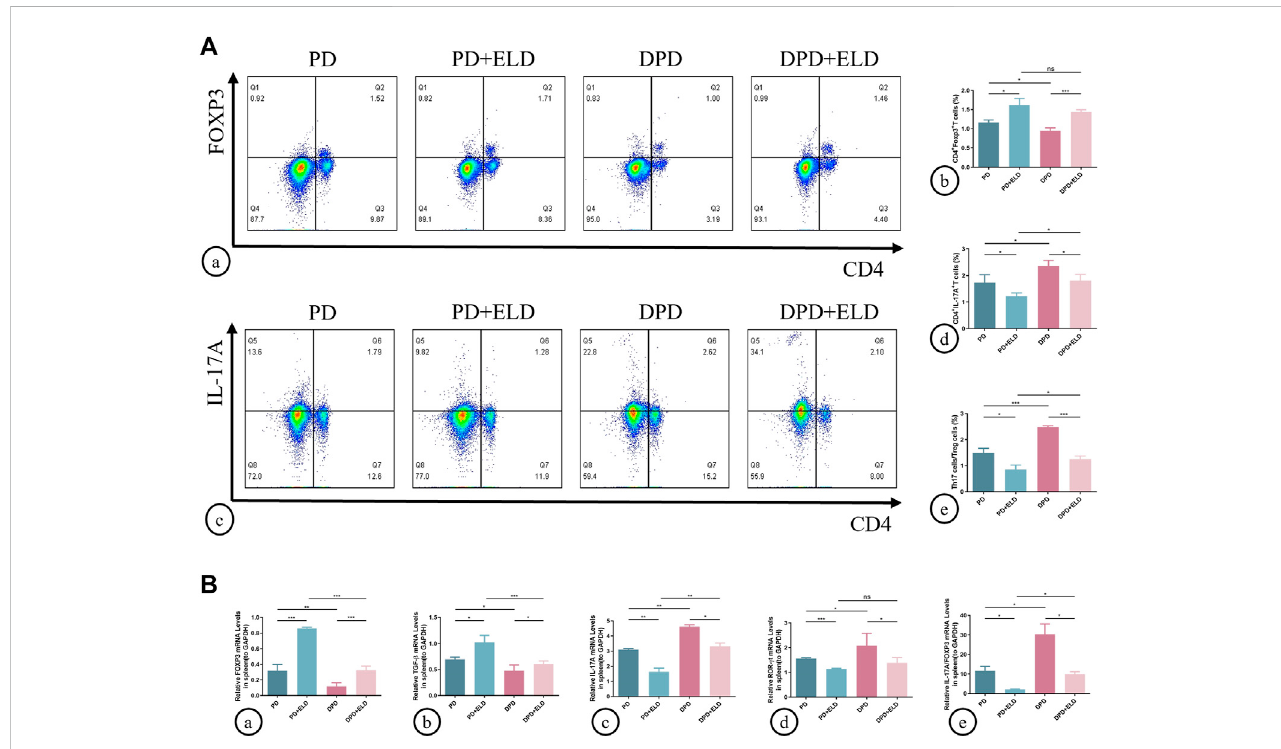
FIGURE 5 Flow cytometryand qRT-PCR analysisof Th17and Treg cells with ELD treatment in spleen lymphocytes. (A) (a) Flow cytometry analysis of CD4 + FOXP3 + Tcells (in the upperrightquadrant) in thespleenlymphocytes in thePD, PD + ELD, DPD and DPD + ELD groups. (b) Statisticalanalysisof CD4 + FOXP3 + T cells inthespleenlymphocytes.(c)FlowcytometryanalysisofCD4 + IL-17A + Tcells(intheupperrightquadrant)inthespleenlymphocytesinthePD,PD+ELD,DPD and DPD + ELD groups. (d) Statistical analysis of CD4 + IL-17A + T cells in the spleen lymphocytes. (e) The ratio of Th17/Treg cells. (B) Relative mRNA expression levels of (a) FOXP3, (b) TGF- β , (c) IL-17A, (d) ROR- ɣ t and (e) theratio of IL-17A/FOXP3 in the PD, PD + ELD, DPD and DPD + ELD groups. Data were shown as mean ± SD (* p < 0.05. ** p < 0.01. *** p <